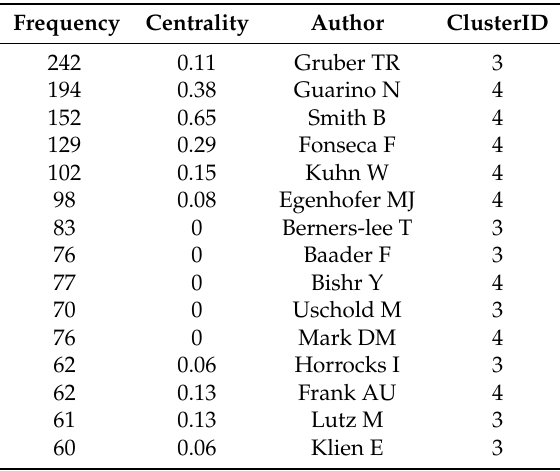
Table 2. The profile of the 15 most co-cited